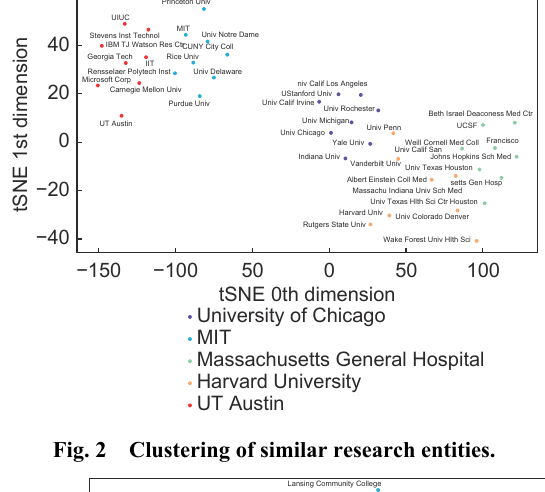
Fig. 2 Clustering of similar research entities.